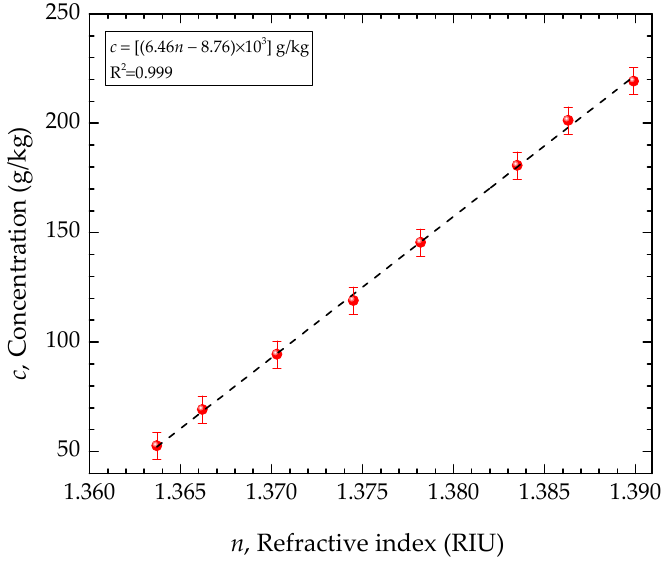
Figure 3. Concentration of paracetamol in solution as a function of refractive index. Measurements of refractive index performed using an Abbe refractometer.